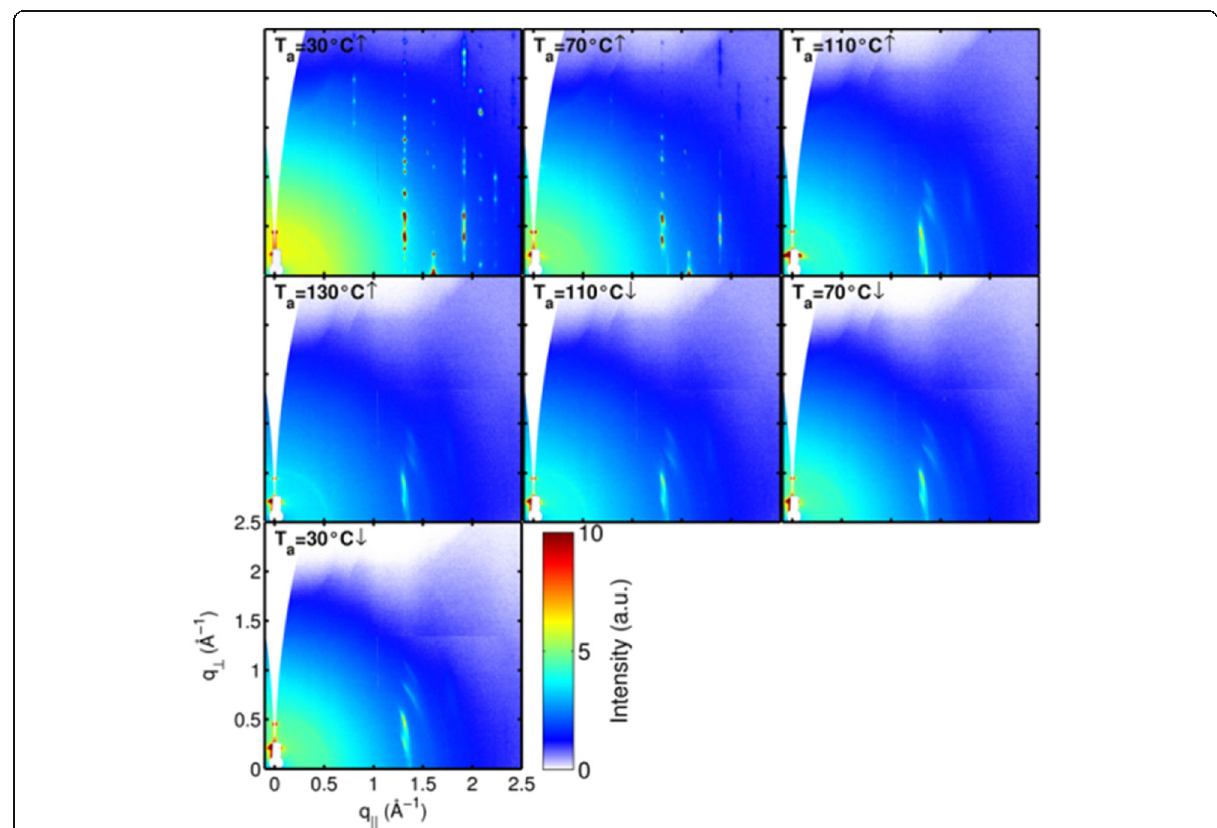
Fig. 3 2D-GIXD patterns of the DH4T film acquired at different temperatures